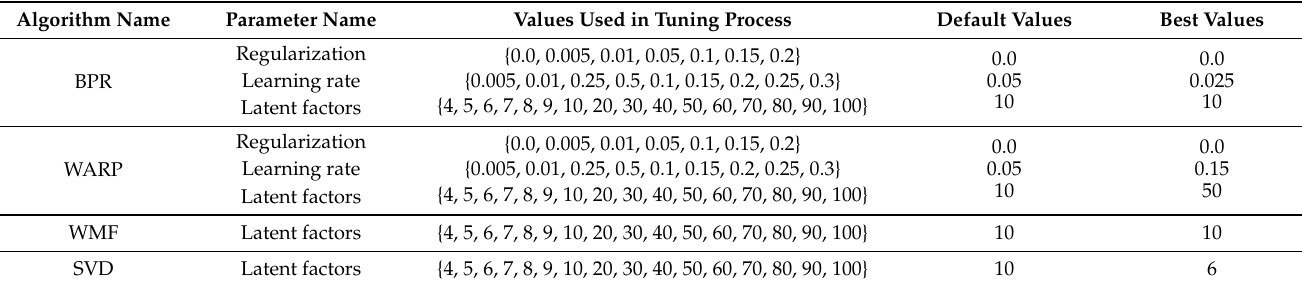
Table 1. The recommendation algorithms parameters that were used during the tuning process.